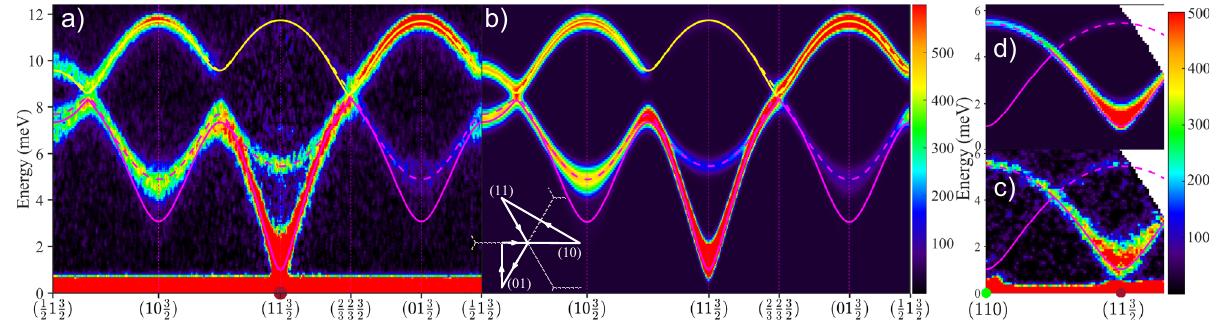
Fig. 1 Magnon dispersions. INS data at 8 K observing the magnon dispersions along high-symmetry directions a in-plane and c out-of-plane, compared in b and d with the XXZ Δ model. Lines are the model dispersions ~ ω ð k Þ , green/brown dots on the elastic line indicate location of structural/magnetic Bragg peaks. Lower left inset in b shows the wavevector path in a , b (arrowed solid white lines) projected onto the ( hk ) plane, grey dashed lines are the 2D Brillouin zone boundaries. Intensities are averaged for a transverse wavevector range of ±0.1 Å − 1 . The incident neutron energy was E i = 18 meV in a and 9.6 meV in c . The colour bars indicate scattering intensity in arbitrary units on a linear